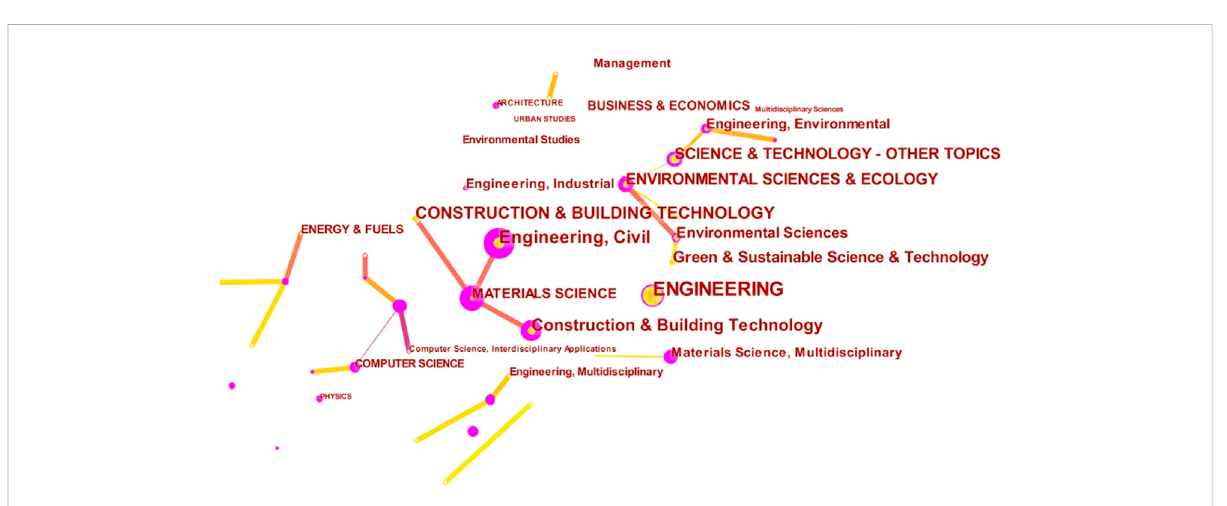
FIGURE 2 Knowledge mapping of research category